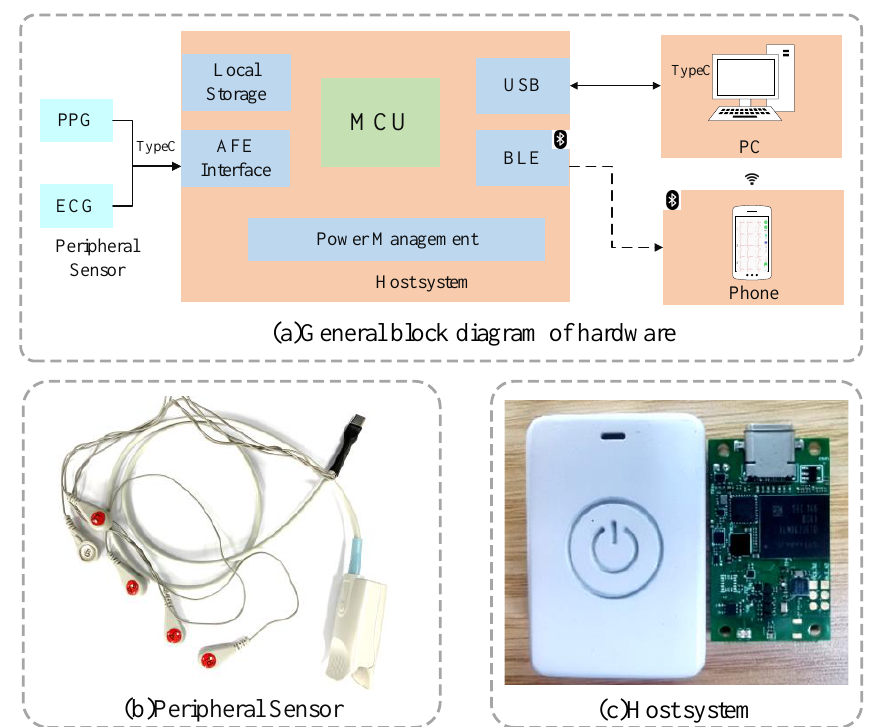
Figure 1. Hardware system. ( a ) General block diagram of hardware; ( b ) Peripheral sensor; ( c ) Host system.